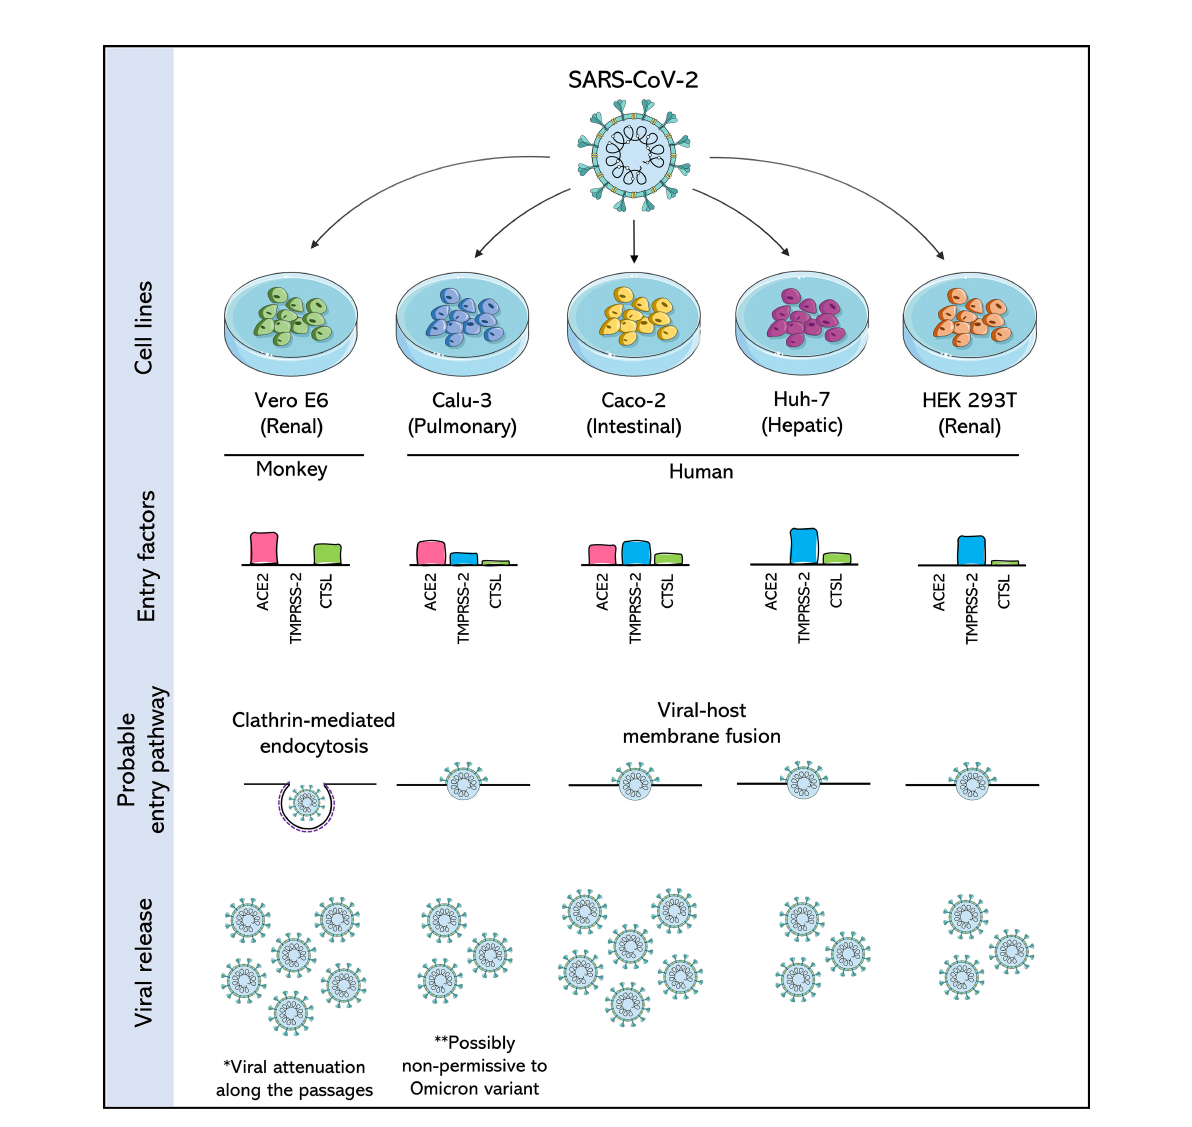
FIGURE 2 Comparison of SARS-CoV-2 permissive cell lines. Four human cell lines: Calu-3 (Pulmonary), Caco-2 (Intestinal), Huh-7 (Hepatic) and HEK 293T (Renal), are compared with each other and with the Vero E6 cell, a cell derived from the African green monkey kidney, and widely used in the isolation and production of SARS-CoV-2. Cells are compared for the expression of three important entry factors used by SARS-CoV-2: angiotensin-converting enzyme 2 receptor (ACE2), transmembrane protease serine 2 (TMPRSS2) and the lysosomal protease cathepsin L (CTSL), based on data from Murgolo et al., 2021; Saccon et al., 2021 and Shuai et al., 2020. The expression of these factors dictates the entry pathway used by SARS-CoV-2. The release of SARS-CoV-2 viral particles is also compared. The asterisks draw attention to likely consequences of producing SARS-CoV-2 in these